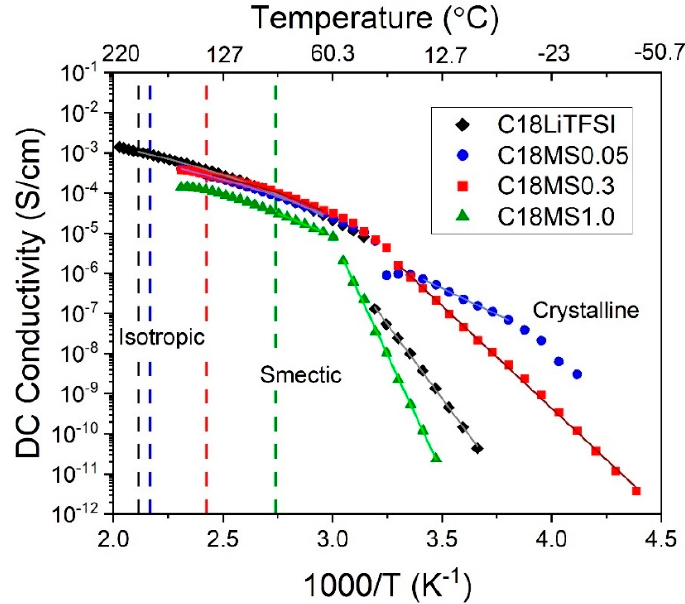
Figure 5. DC conductivity of C18MS mixtures by temperature compared to pure C18LiTFSI measured by dielectric impedance spectrometry. Isotropic to smectic transition values measured using DSC are indicated by vertical lines for each material, and regressions calculated based on Arrhenius or VTF models are displayed as fit lines. Data for C18LiTFSI were originally reported in [21].